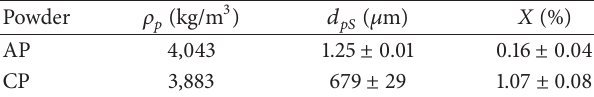
Table 1: Physical properties and moisture content of powders.